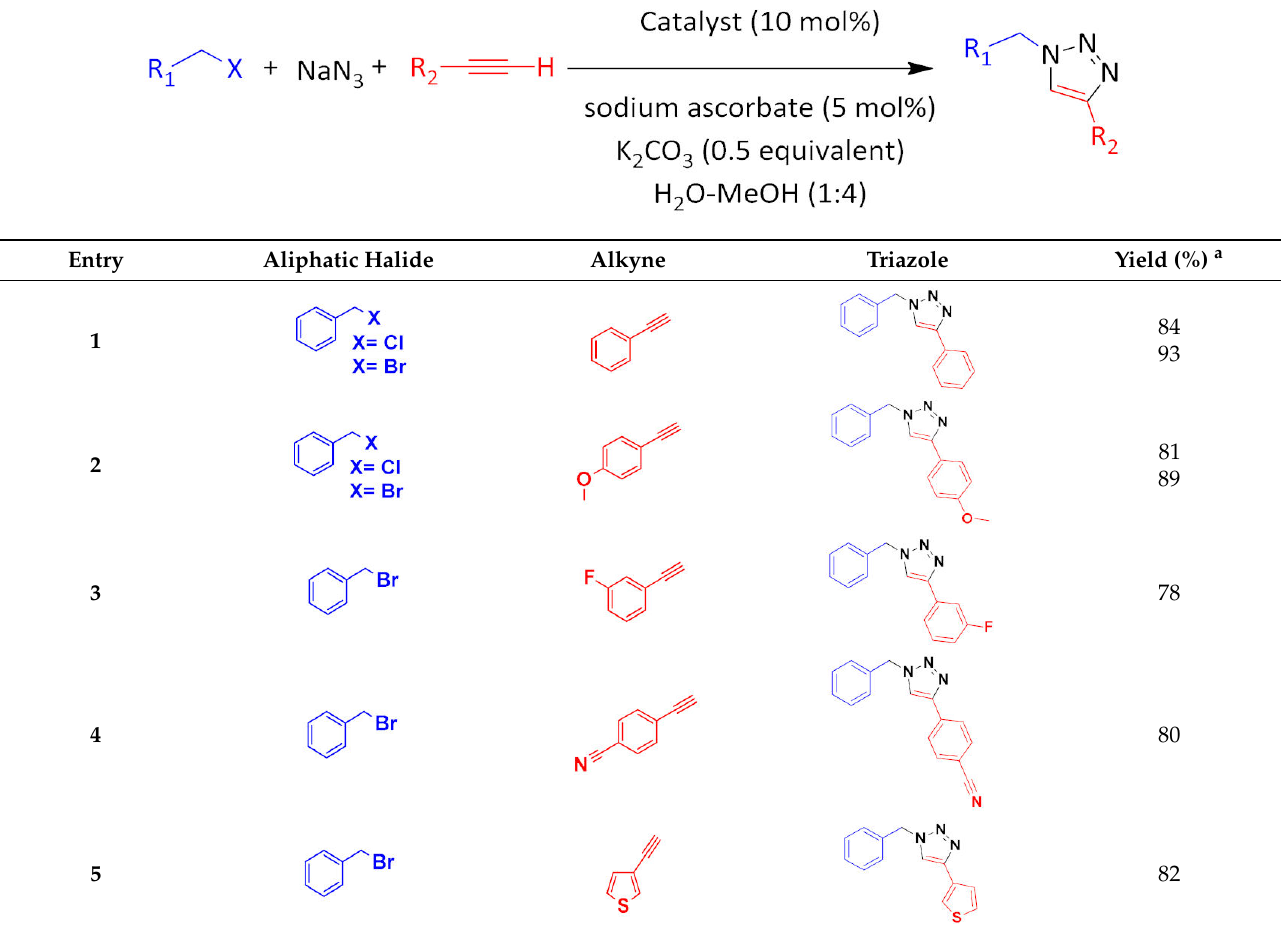
Table 3. Cu-MOF catalyzed one-pot azide preparation from organic halide followed by cycloaddition with terminal alkyne.